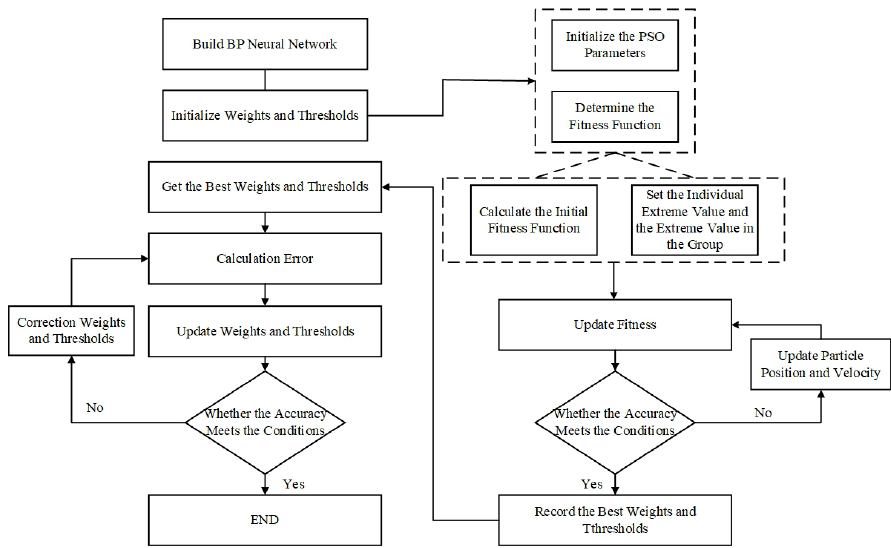
Figure 4. Implementation process of the PSO-BP